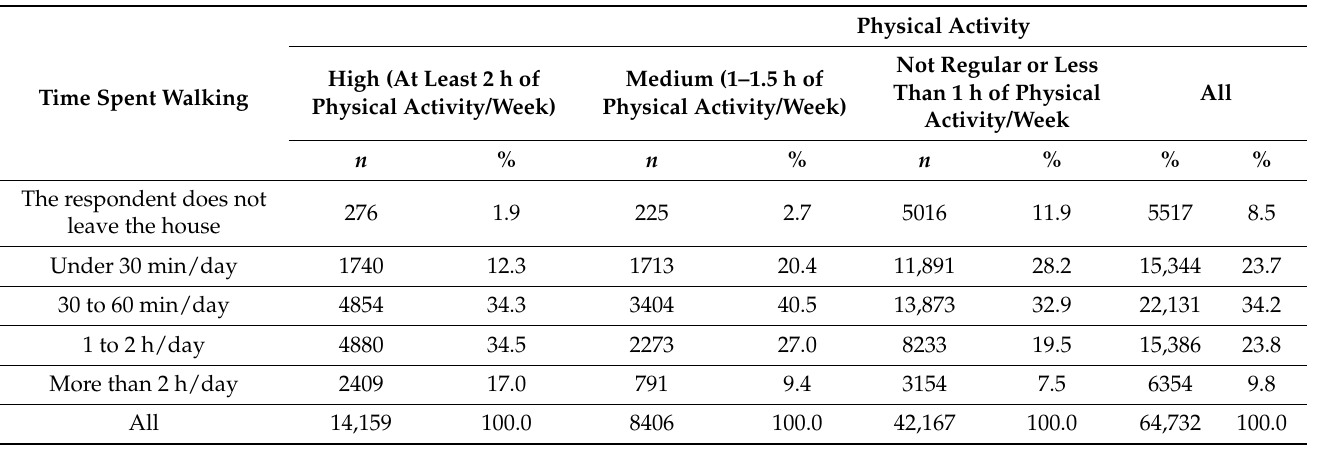
Table 3. Prevalence of physical activity on the form of active sport participation and